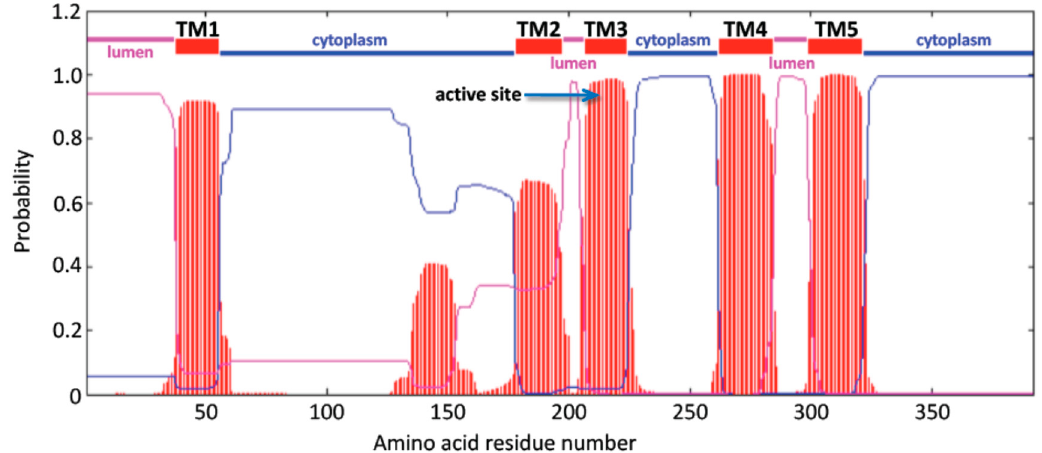
Figure 2. Predicted transmembrane organization for human CERS6 enzyme. Regions of hydrophobicity are shown as striped red segments, with five transmembrane domains (TM1–5) identified (TMHMM Server v. 2.0, DTU Bioinformatics, Kongens Lyngby, Denmark). Predicted lumenal and cytoplasmic regions are shown in magenta and blue lines; the His211-His212 residues of the active site were positioned within TM3. Y -axis: probability (0–1) of forming a transmembrane helix; X -axis: amino acid position within human CERS6.